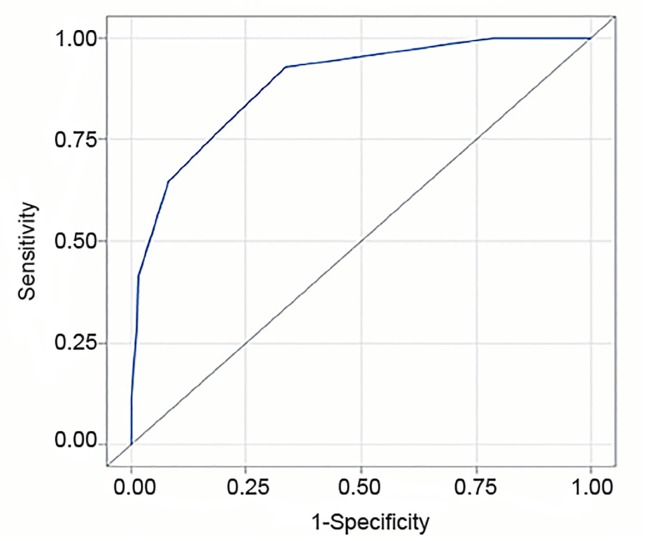
The area under the receiver operating characteristic (ROC) curve using a Surgical Intervention for Traumatic Injury (SITI) score of 3 as the threshold.Area under the curve = 0.8866.